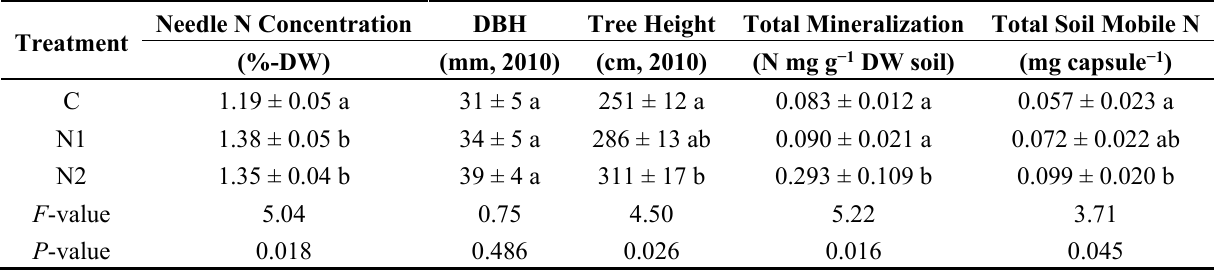
Table 3. The mean (± 1 SE) tree needle N concentration (%-DW), diameter at breast height (DBH, mm), tree height in 2010, the total mineralization rates (NH 4 -N and NO 3 -N mg g − 1 DW soil) and the total soil mobile N (NH 4 -N and NO 3 -N) concentration. The 10 year old trees grew on sites never fertilized (C), fertilized once with 150 kg·N·ha −1 during the previous stand rotation (N1) and fertilized twice with 150 kg·N·ha −1 during the previous stand rotation (N2). Different lower case letters (a or b) besides means in each column indicate significant post hoc differences between treatments (Tukey’s HSD